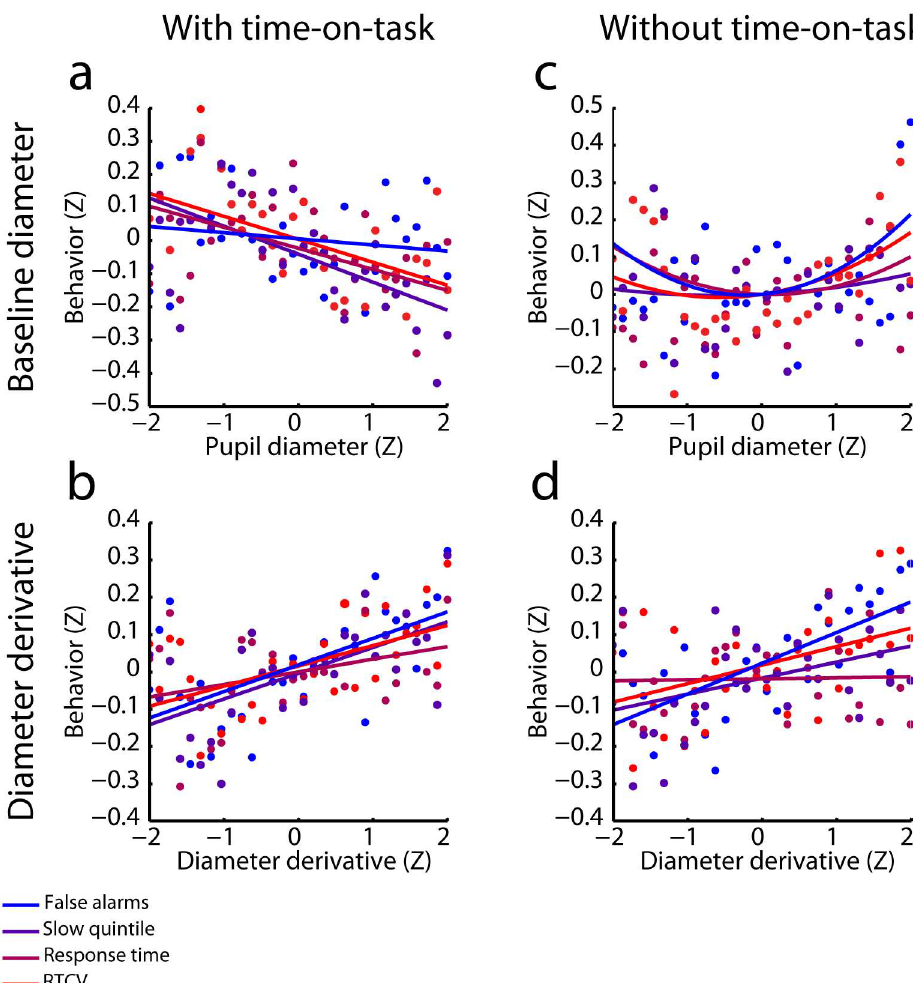
Fig 5. Relationship between pupillary measuresand behavior, before (a,b) and after (c,d) regressing out time-on-task. Pupil data were z-scored within participants and blocks, aggregated across participants, and then divided up into 30 bins, and the behavioraldata were sorted accordingto pupil diameter. Large positive values on the Y-axis indicate relatively poor behavioral performance. The initially linear relationship between baselinediameter and behaviorbecomes U-shapedafter controllingfor time-on-task, whereas the relationship between the derivative of baseline diameter and behaviorremains linear after controllingfor time-on-task. Straight lines are least squares regressionlines, curved lines are fitted 2 nd -order